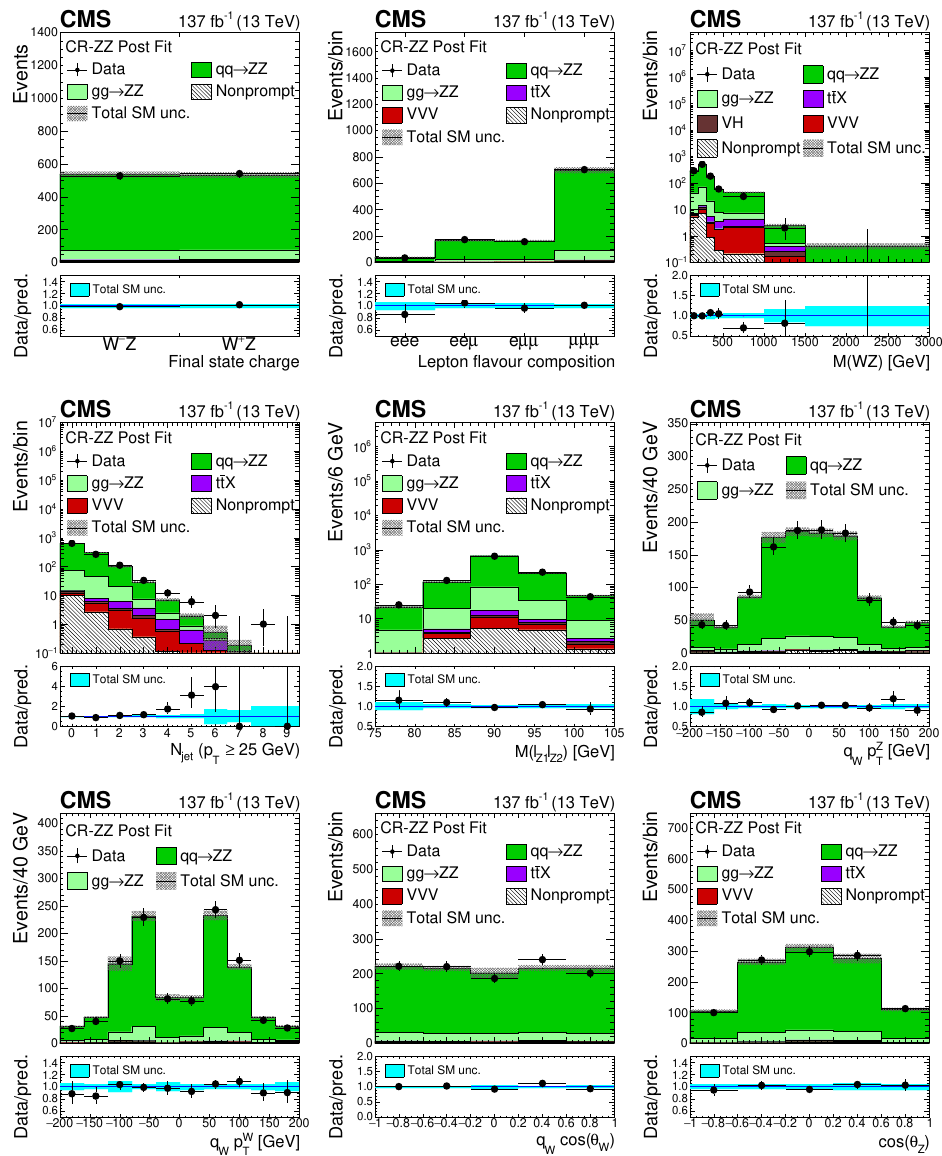
Figure 2 . Distribution of observables in the ZZ control region evaluated with the uncertainties obtained after the signal extraction fit described in section 8. From left to right and top to bottom: charge of the system of the three leading leptons, their flavour distribution, invariant mass of the three lepton plus p miss system, number of reconstructed jets, invariant mass of the leptonic pair T with mass closest to that of the Z boson, reconstructed p of the Z boson times charge of the three T leading lepton final state, reconstructed p of the W boson times final-state charge constructed with T and the three leading lepton system, cosine of the polarization angle of the W boson multiplied p miss T by the boson charge, and cosine of the polarization angle of the Z boson. The polarization angles are described in section 10. The label ttX includes ttZ , ttW , and ttH production. The shaded band in the main plot area and the blue band in the ratio show the sum of uncertainties in the signal and background yields. The vertical bars attached to the data points show their associated statistical uncertainty. Underflows (overflows) are included in the first (last) bin shown for each